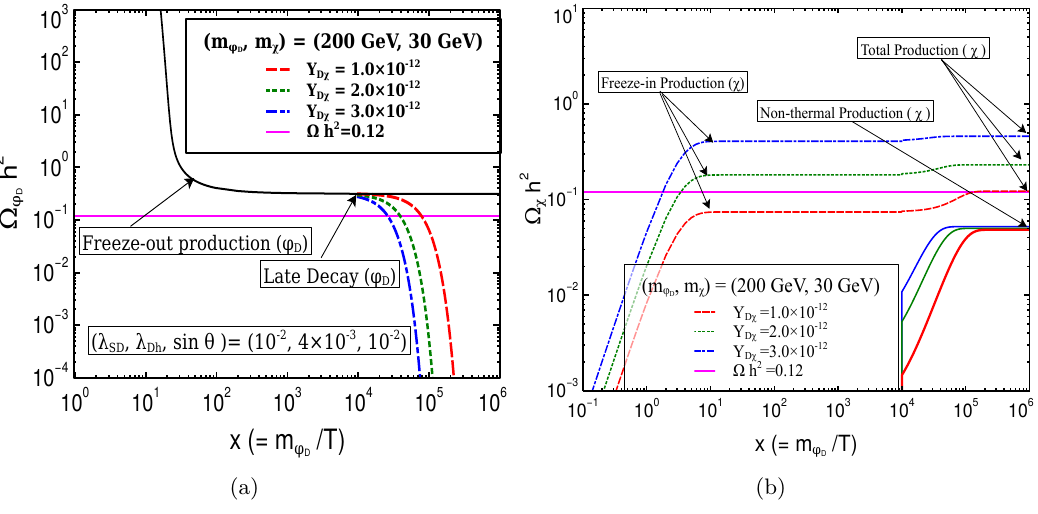
Figure 10 . Left panel: figure 10(a) shows the variation of Ω φ h 2 w.r.t. x . Right panel: figure 10(b) D shows the variation of Ω 2 w.r.t. x . This corresponds to a mixed scenario, where both the freeze-in χ h and super-wimp contributions are